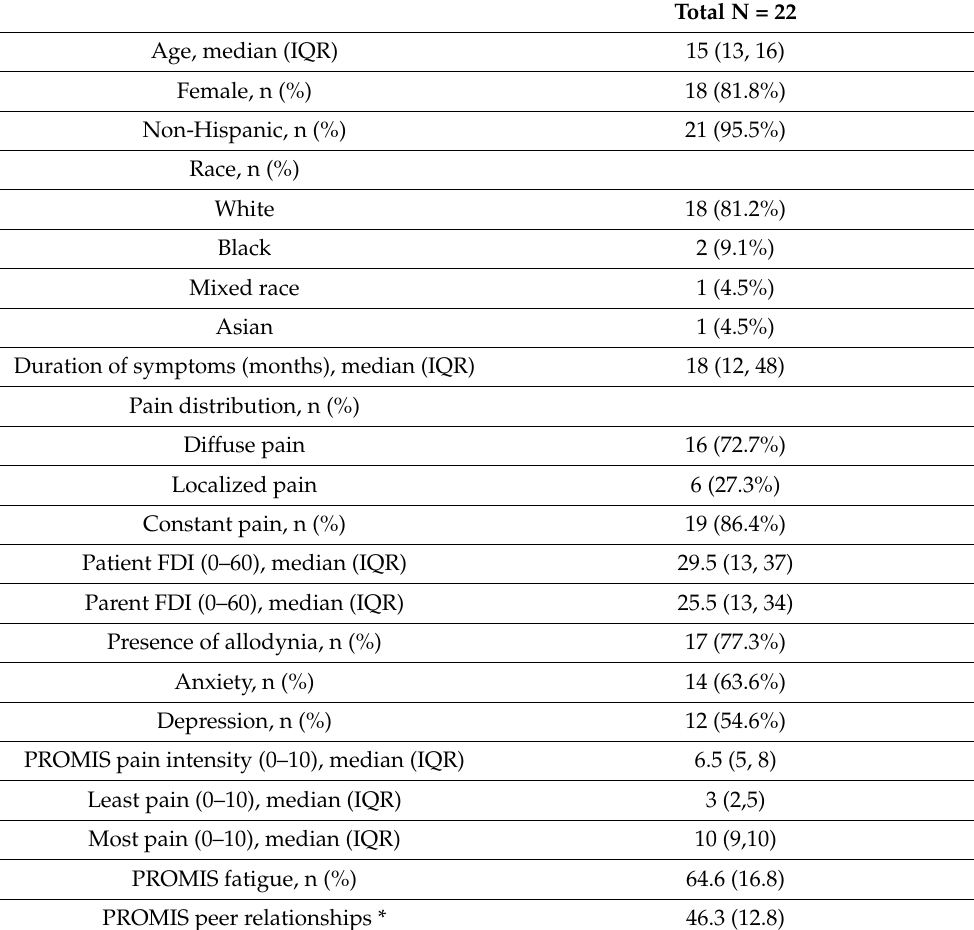
Table 2. Pre-intervention demographics and clinical